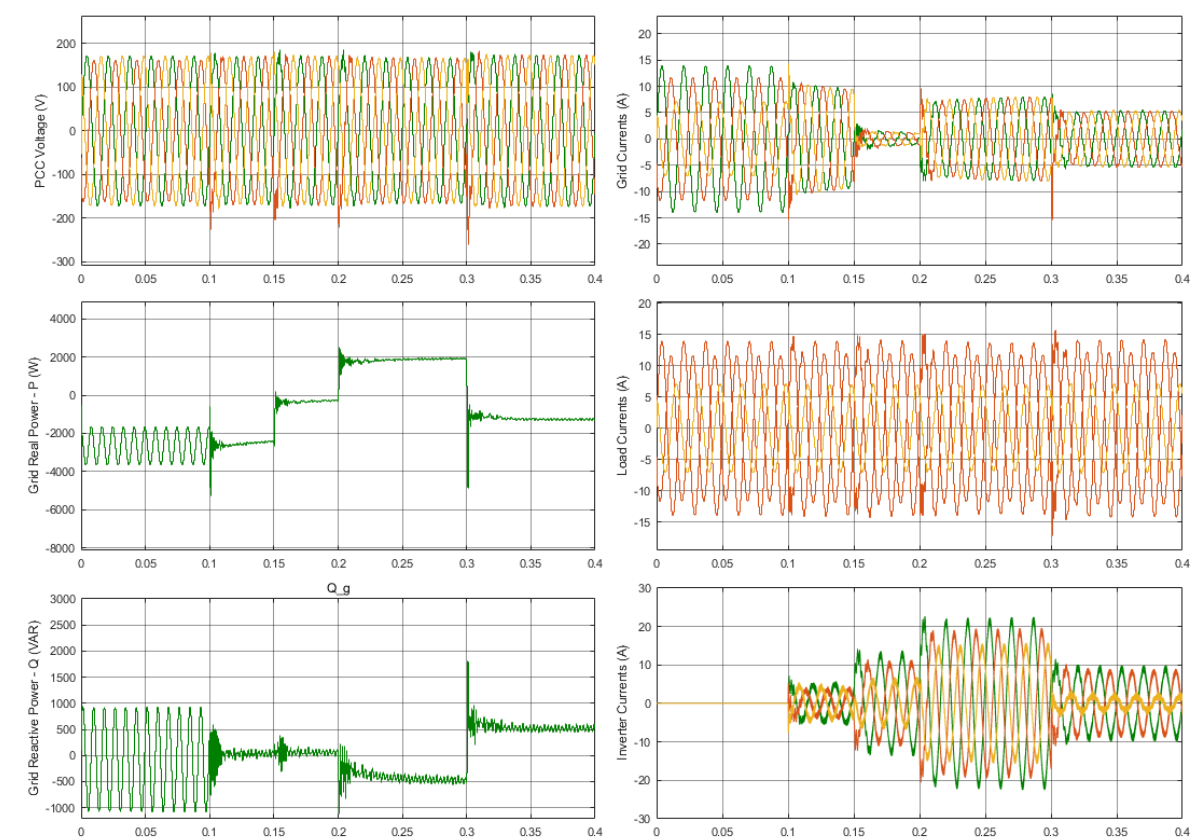
Figure 9. Simulation results under balanced grid